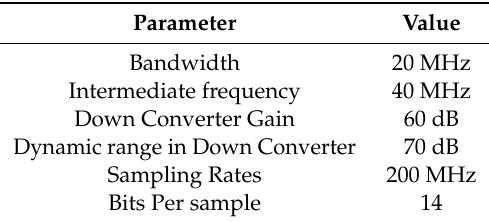
Table 1. Down-converter digitizer